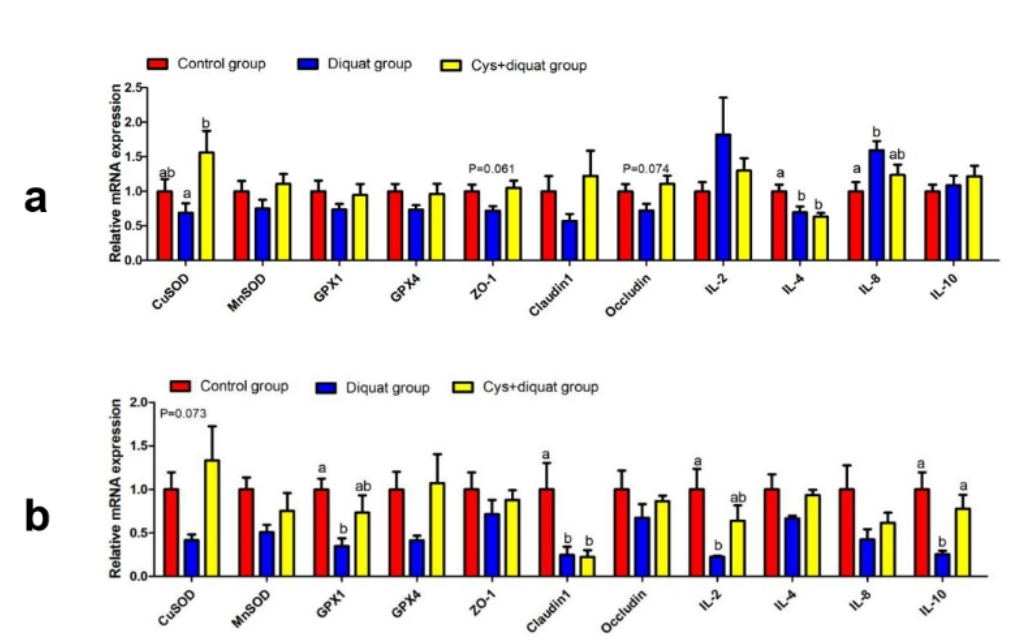
Figure 2. Effects of dietary supplementation of coated cysteamine on the expression of genes related to antioxidant, tight junction and inflammation in pigs ( a ) jejunum and ( b ) colon. CuSOD: Cu-SOD; MnSOD: Mn-SOD; GPX1: glutathione peroxidase 1; GPX4: glutathione peroxidase 4; ZO-1: zonula occludens-1; IL-2: interleukin-2; IL-4: interleukin-4; IL-8: interleukin-8; IL-10: interleukin-10. Results are expressed as means ± SEM (n = 8). Means in the same row with different letters were significantly different ( p < 0.05).